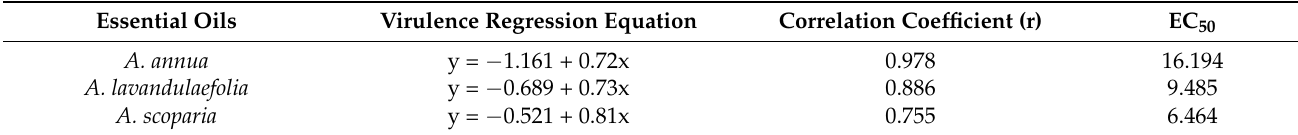
Table 2. EC 50 value of three essential oils from Artemisia species against C. gloeosprioides in vitro fumigation (μ L/plate). Essential Oils